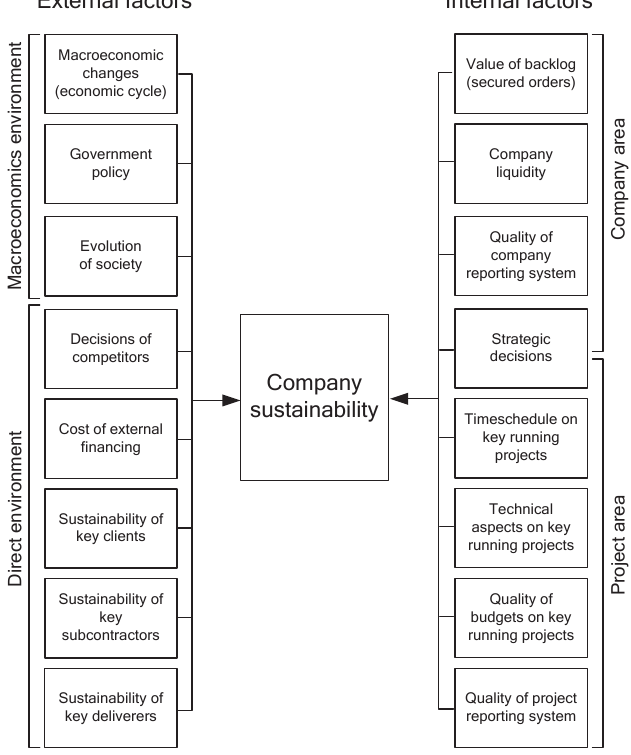
Fig. 1. Major sources influencing the sustainability of a project-based company (developed by the